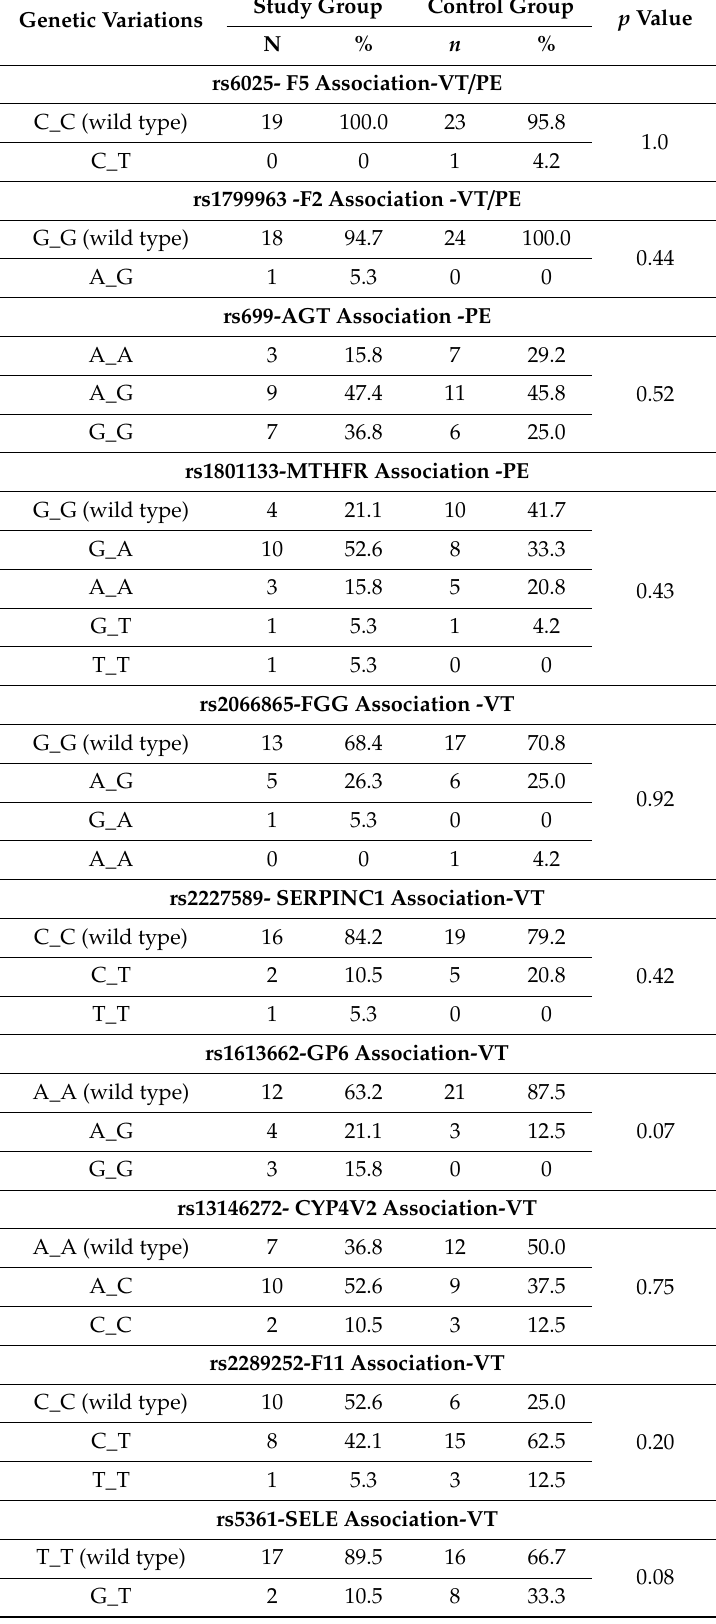
Table 3. Polymorphisms in the study and control groups according to